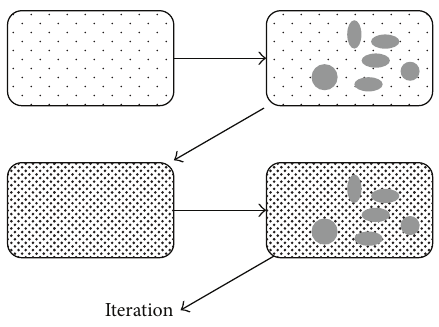
Figure 1: Schematic diagram of the differential scheme